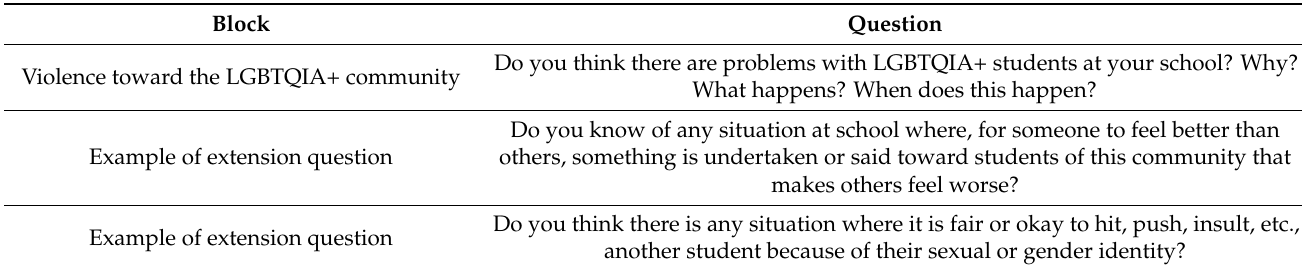
Table 1. Example of questions asked to the focus